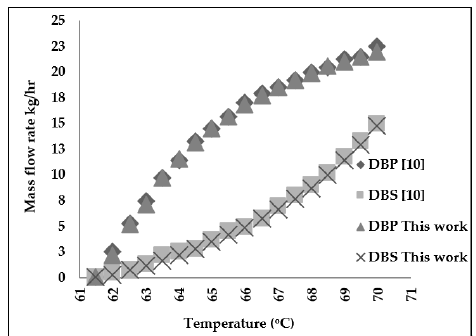
Figure 1. Comparison of distillated mass flow rate in study [10] and this work as a function of flash vessel operating temperature (°C).